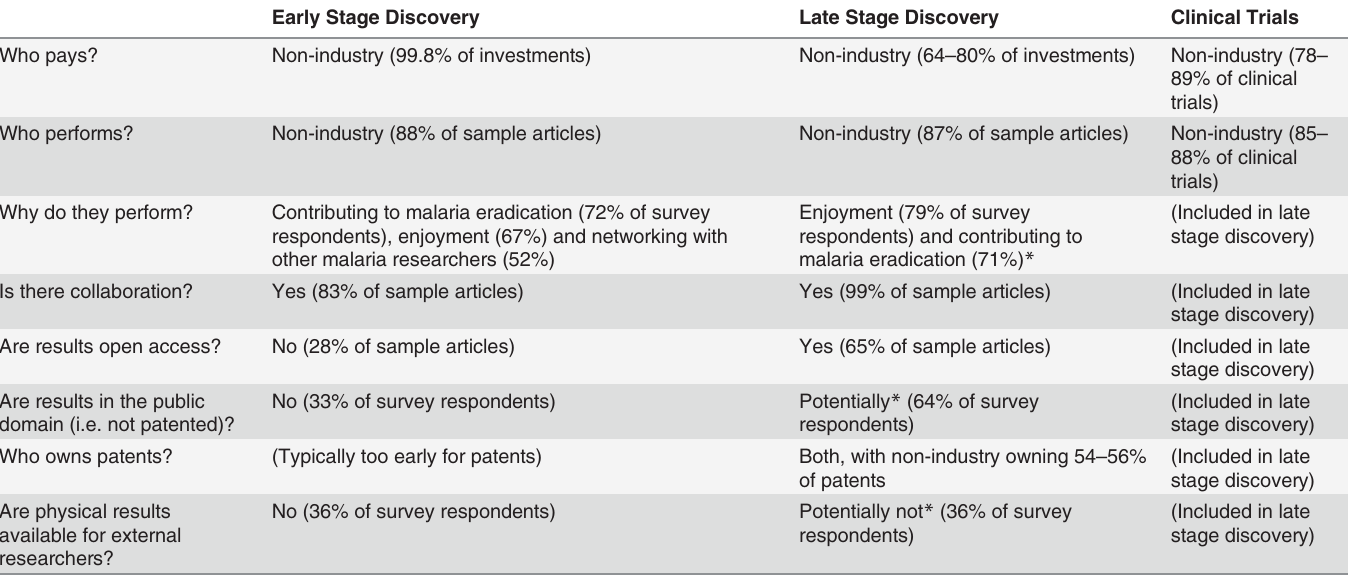
Table 2. A summary of our fi ndings regarding malaria medicine and vaccine